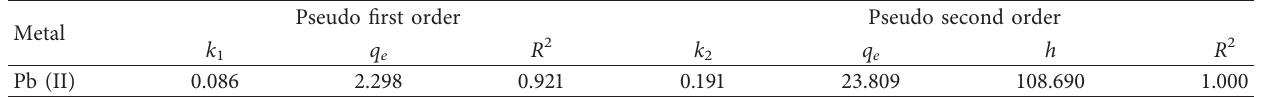
Figure 10: Pseudo-first- and Pseudo-second-order kinetics for adsorption of Pb (II). (a) 1st order and (b) 2nd order. Table 3: Kinetics parameters of adsorption of Pb